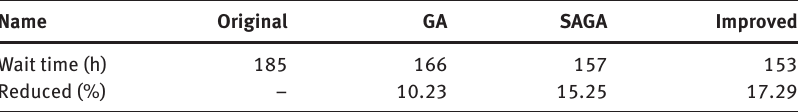
Table 4. Optimal Result Comparison of Improved Hybrid Heuristic Algorithm, GA, and